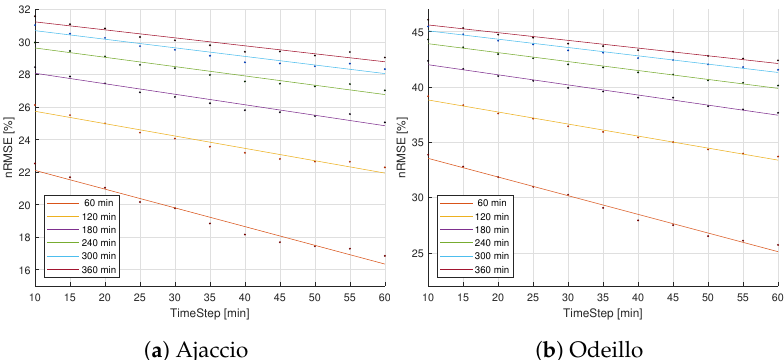
Figure 10. Error (nRMSE) vs. time-steps ( ∆ t ) for time-step 10 to 60 min and horizons 1 to 6